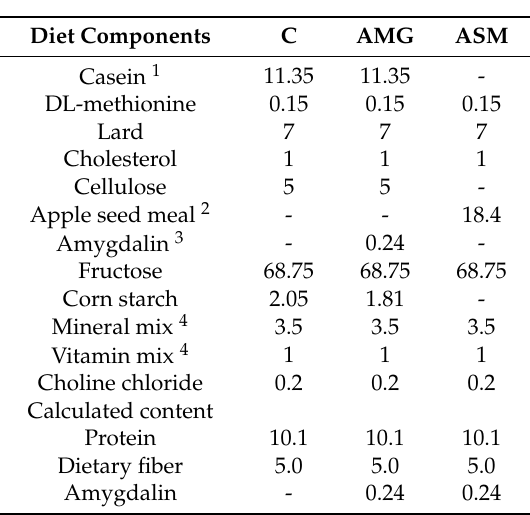
Table 1. Composition of rat diets